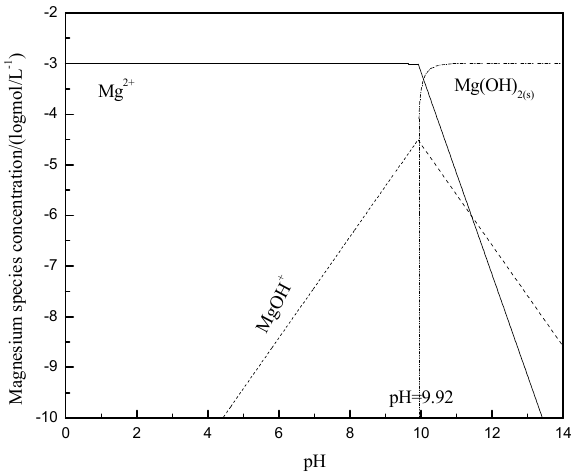
Figure 8. Calculated concentration of magnesium species in solution with 1 × 10 − 3 mol/L Mg 2+ .